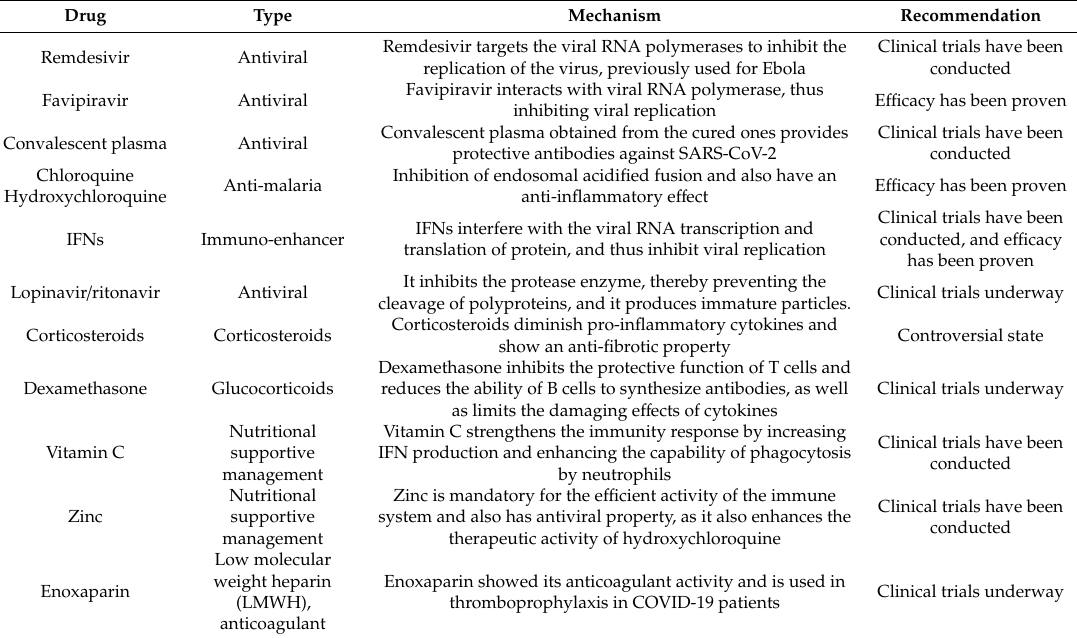
Table 5. Potential therapeutics against SARS-CoV-2 (COVID-19) [68,105,112,116,125–130]. IFNs, interferons.